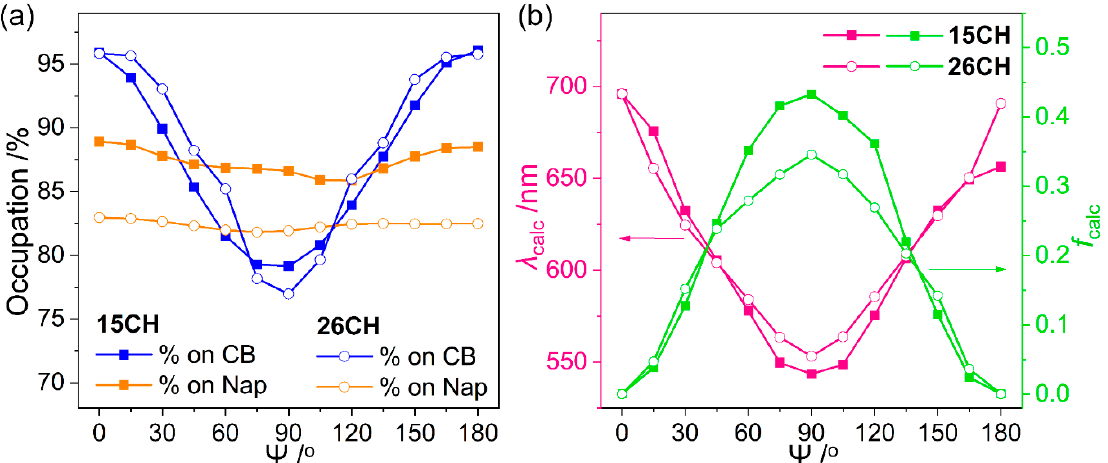
Figure 5. ( a ) Orbital contributions of the o -carborane cage (CB) and the naphthyl moiety (Nap) to the LUMO and HOMO, respectively, as a function of Ψ in S 1 -optimized structures for 15CH and 26CH . ( b ) Computed emission wavelengths ( λ calc in nm, pink lines) and oscillator strengths ( f calc , green lines) for each low-energy transition (LUMO to